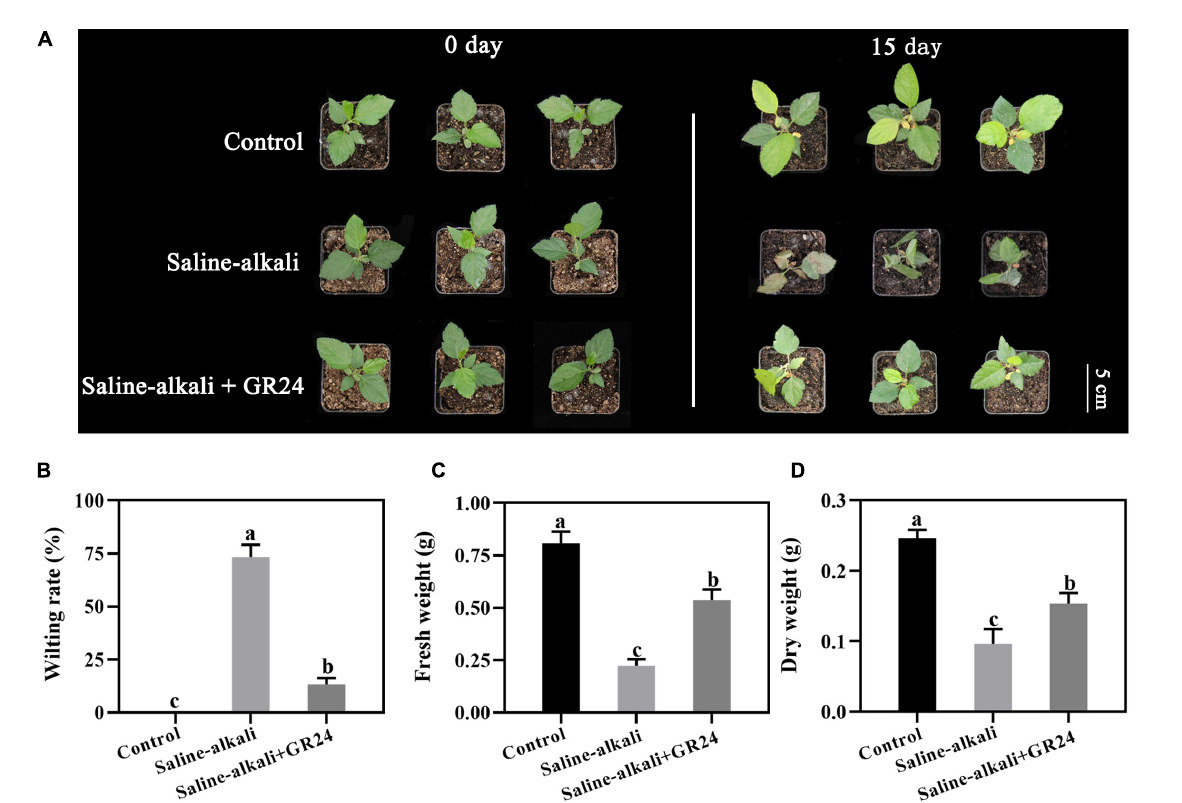
FIGURE1 Phenotypes of Malus hupehensis seedlings treated with salinity-alkalinity stress and exogenous 100 µ M GR24 on day 0 and day 15 (A) . Effect of GR24 on wilting rate (B) , fresh weight (C) , and dry weight (D) of apple seedlings after salinity-alkalinity stress for 15 days. The bar (A) represents 4.0 cm. The data represent the mean ± SD of three biological replicates. Different lowercase letters indicate significant differences according to Fisher’s least significant difference ( P < 0.05).